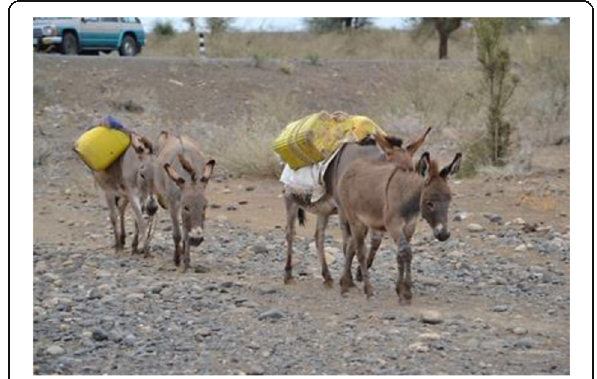
Figure 5 The foals accompany with their mother transporting